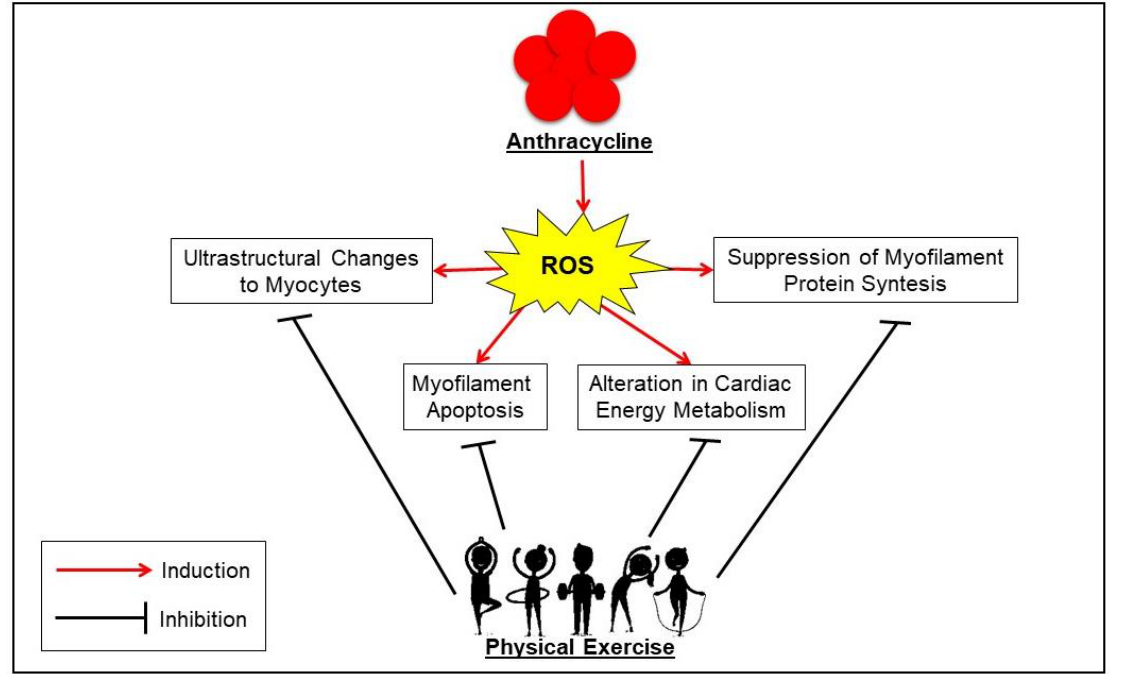
Figure 2. Schematic representation of the mechanisms underlying anthracycline-induced cardiotoxicity and their modulation through physical exercise in breast cancer. Abbreviation: ROS, reactive oxygen species .